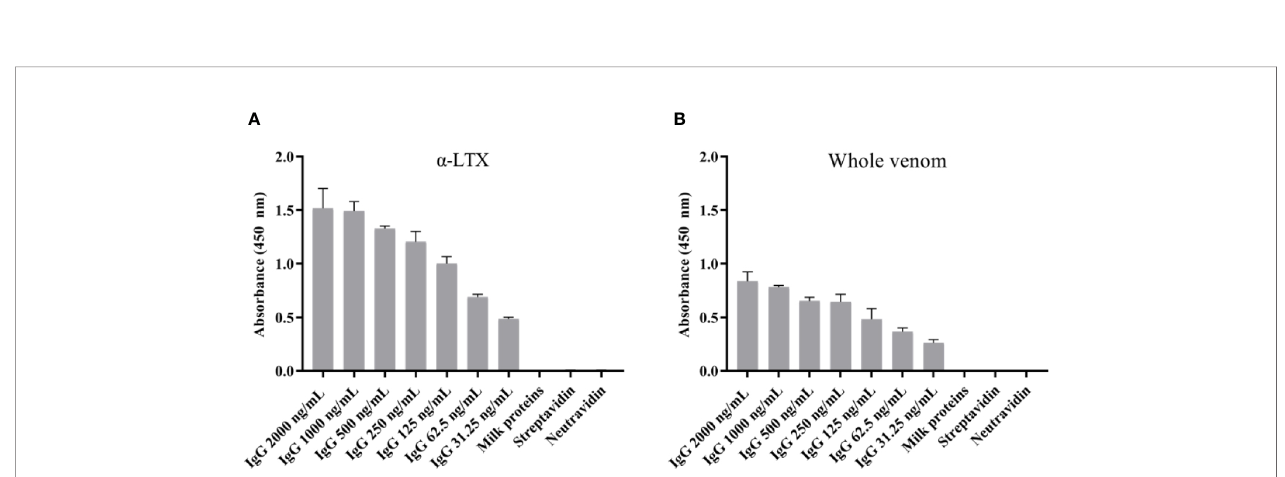
FIGURE 4 | Monoclonal IgG ELISA signals against (A) a -LTX and (B) L. tredecimguttatus whole venom. The binding capability of TPL0020_02_G9 to a -LTX was assessed using different concentrations of IgG. The binding speci fi city was evaluated by testing the binding of the IgG to three controls (binding to milk proteins, streptavidin, and neutravidin) using the highest IgG concentration (2,000 ng/ml). Each column represents the average of triplicate measurements with error bars indicating the standard deviation.